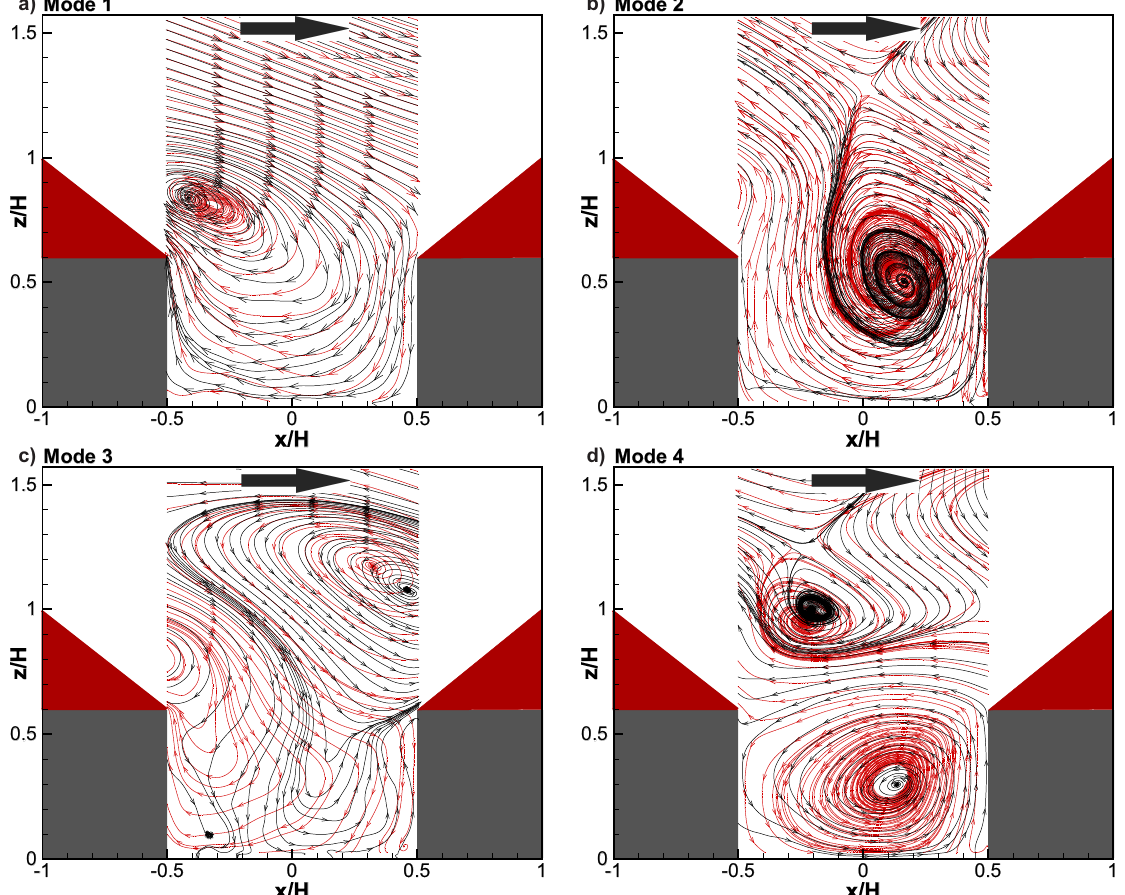
Figure 12. The POD modes for the restricted rectangular area within the street canyon for PIVa and LESa. ( a – d ) correspond to Mode 1–4. The black streamlines denote PIVa, the red streamlines denote LESa. The LESa modes are interpolated on the PIV